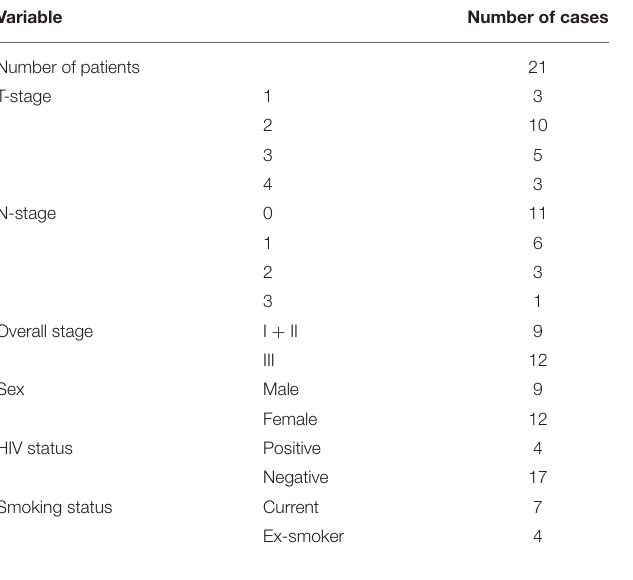
TABLE 2 | Patient and tumor characteristics. Variable Number of cases